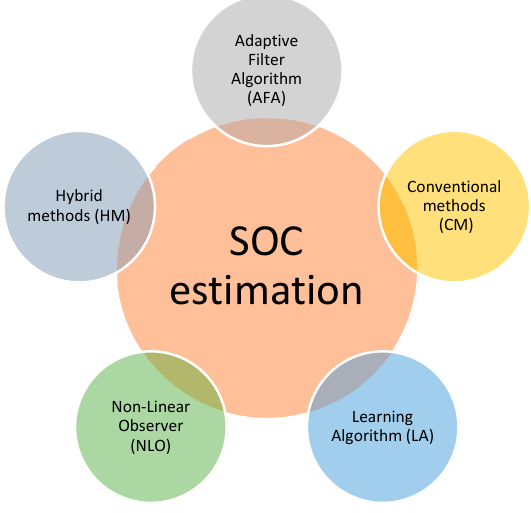
Figure 4. State of charge (SOC) estimation methods.